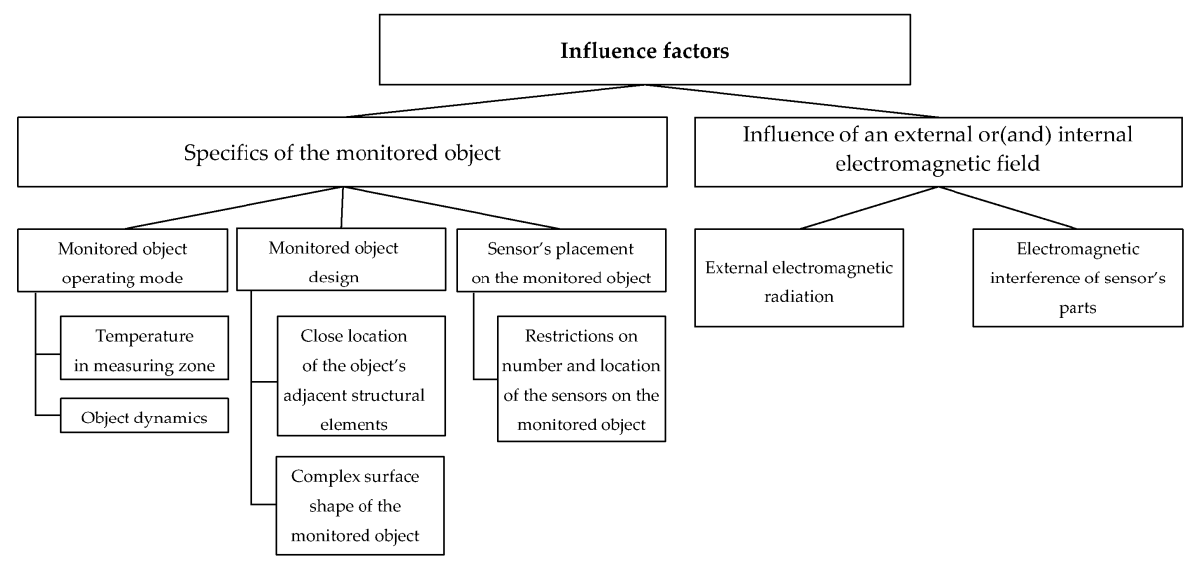
Figure 3. Classification of the factors affecting SCECS.